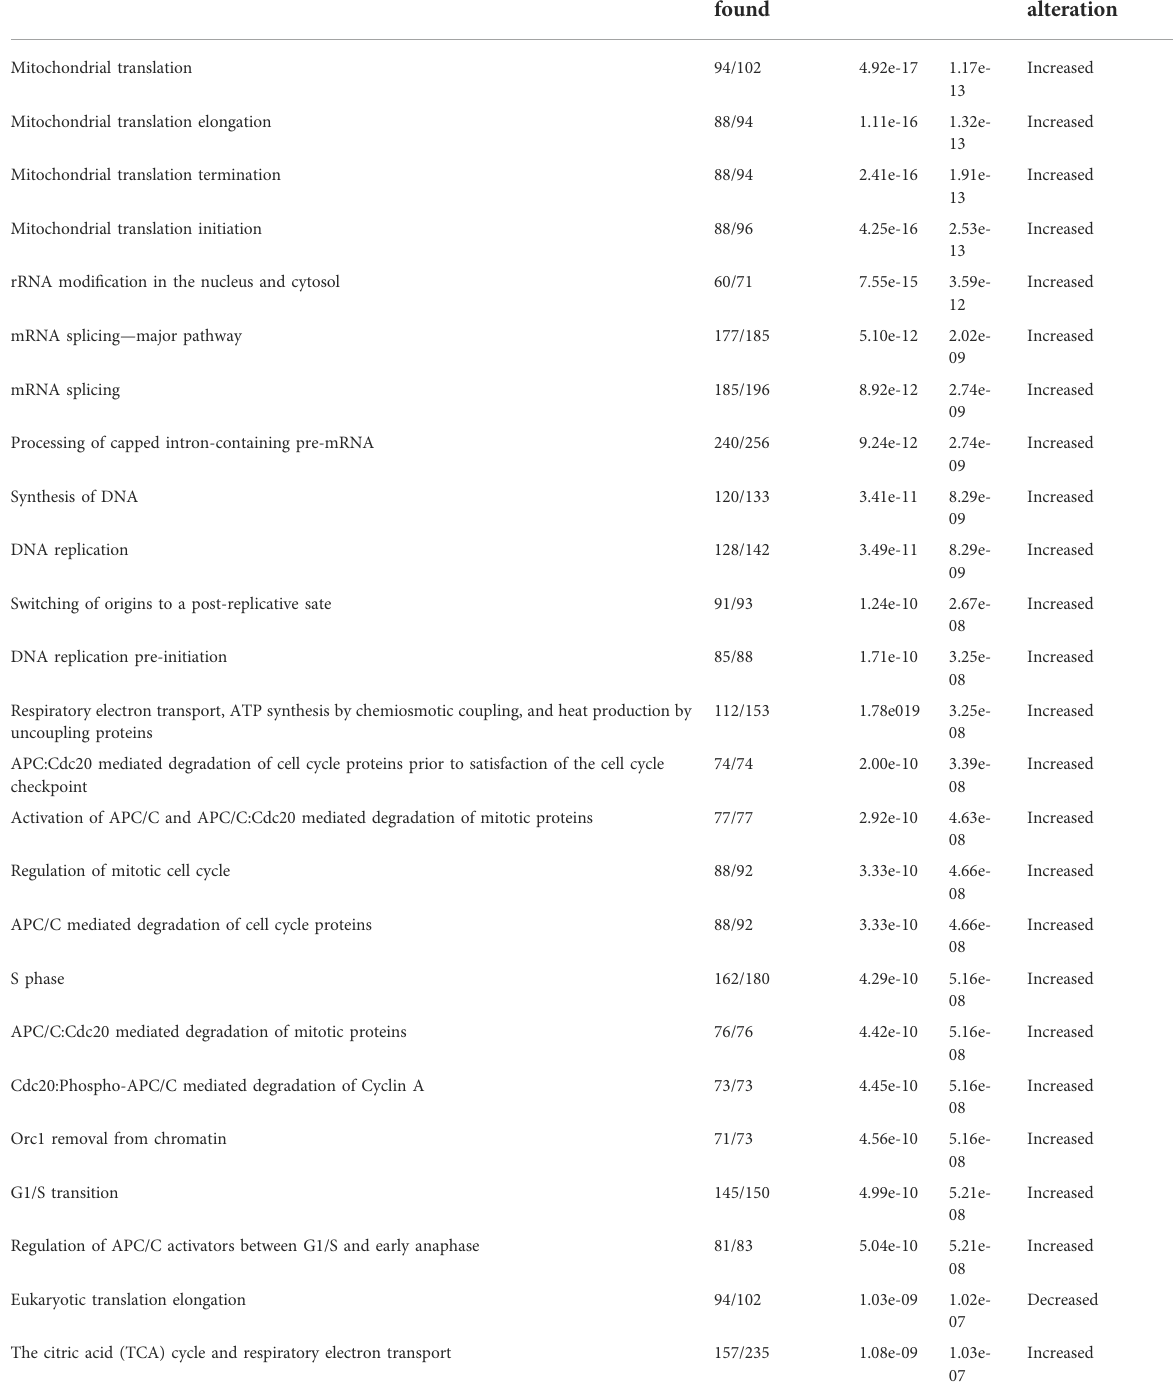
TABLE 4 RNAseq pathway analysis of ACM vs. SCM (all cell lines